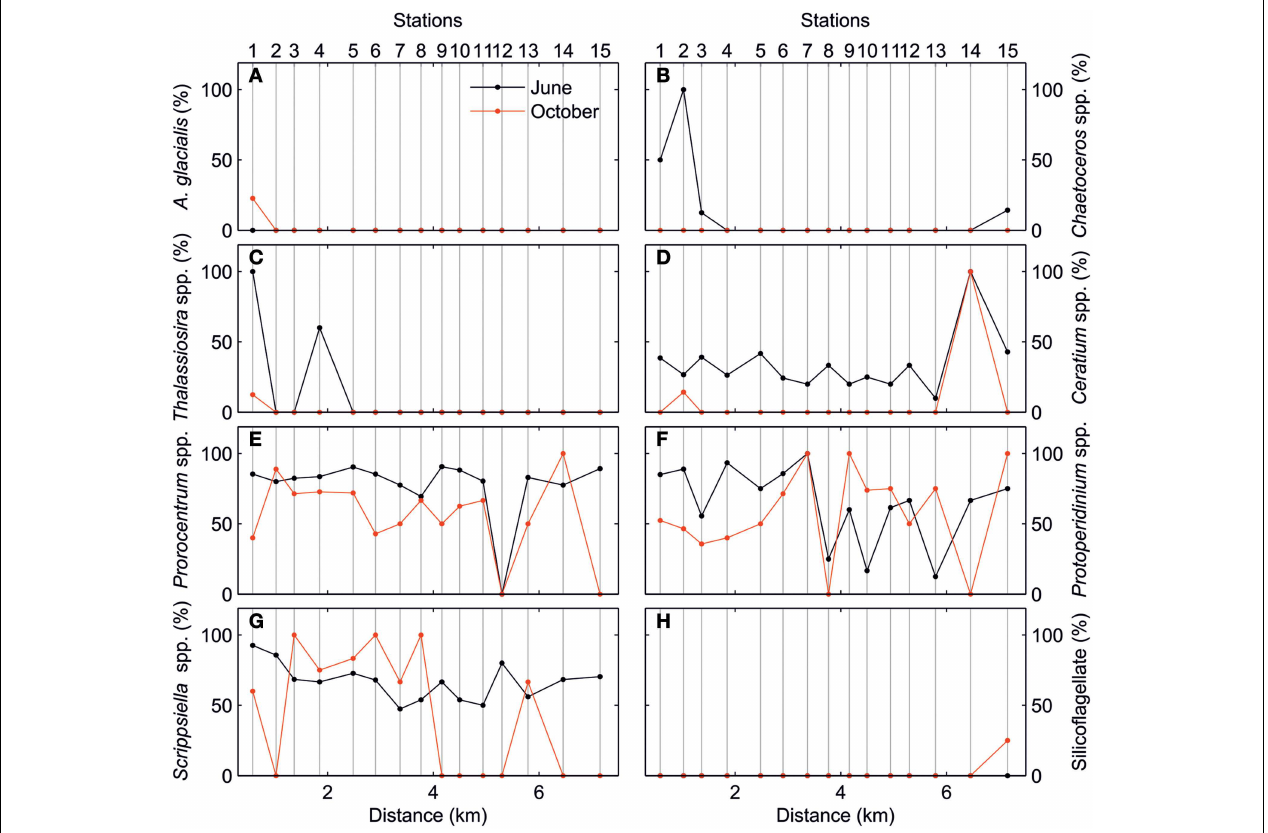
FIGURE 6 | Percentage of ELF-labeled cells (%) of (A) Asterionellopsis glacialis , (B) Chaetoceros spp., (C) Thalassiosira spp., (D) Ceratium spp., (E) Prorocentrum spp., (F) Protoperidinium spp., (G) Scrippsiella spp., and (H) Silicoflagellate for June (black) and October (red) surveys.